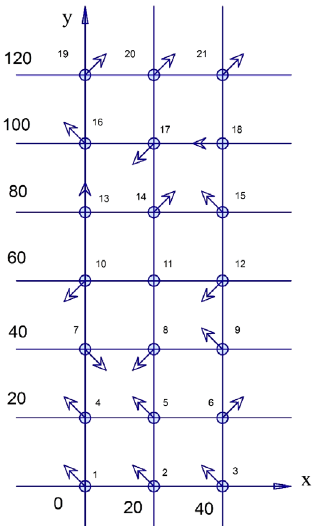
Figure 1. The scheme of placement of points on the equipment and directions of their deviation after deformation The presence of an error in the geodetic measurements